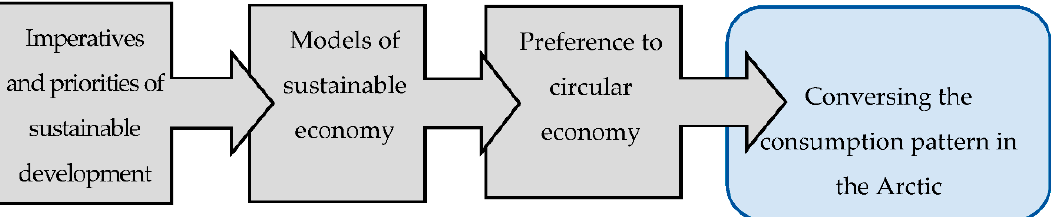
Figure 1. The structural logic of the article.